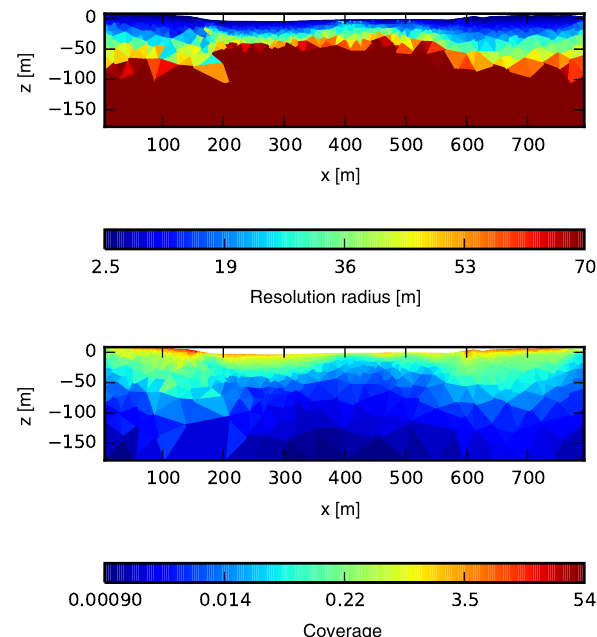
Figure 4. Calculated model resolution radii (a) and coverage (b) for ERT using the Jacobian matrix of the final